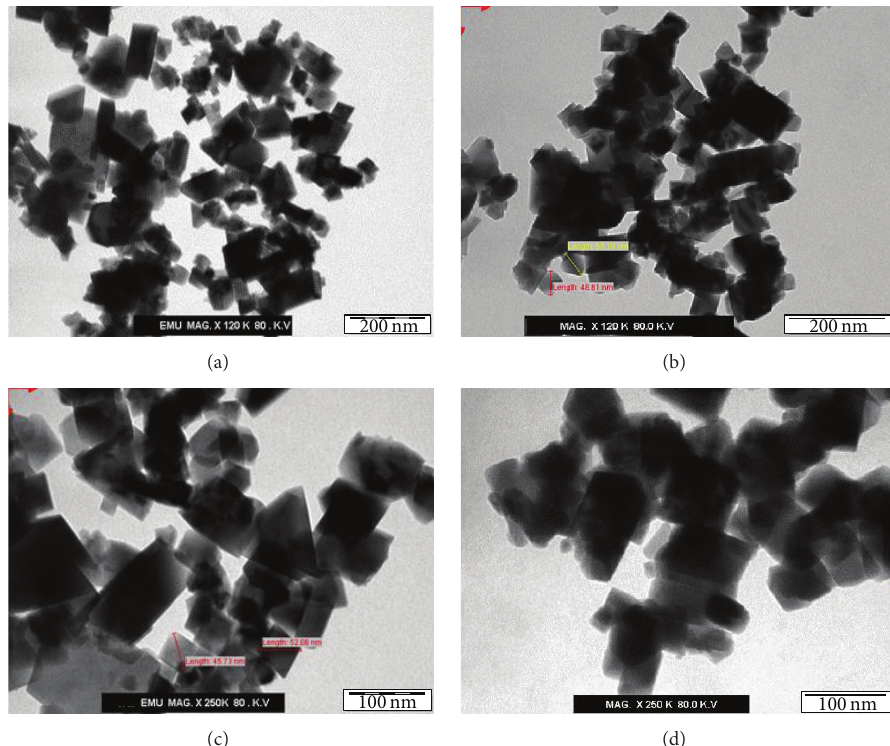
Figure 2: TEM micrographs of naked Fe 3 O 4 nanoparticles ((a), (c)) and Ag-doped Fe 3 O 4 nanoparticles ((b), (d)) at different magnifications.